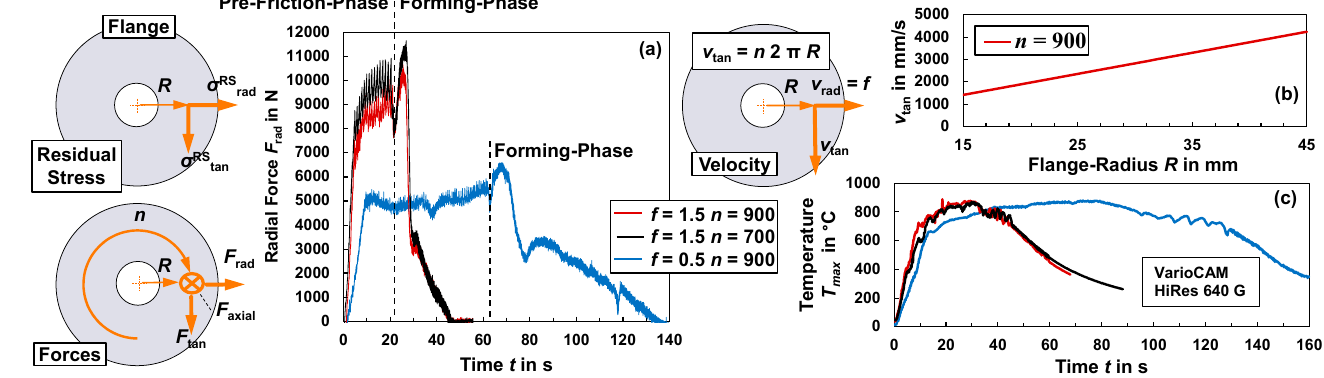
Figure 2. Process characteristics of flange forming by the friction spinning of steel (1.0308) tubes as a function of the process parameters rotation speed n and feed rate f . (a) Radial forces, (b) friction velocity, (c) temperature profile.